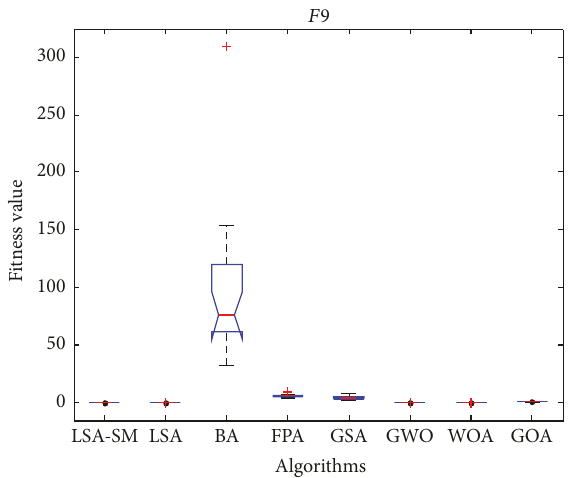
Figure 31: 𝐷 = 30 , ANOVA test of global minimum for 𝑓 09